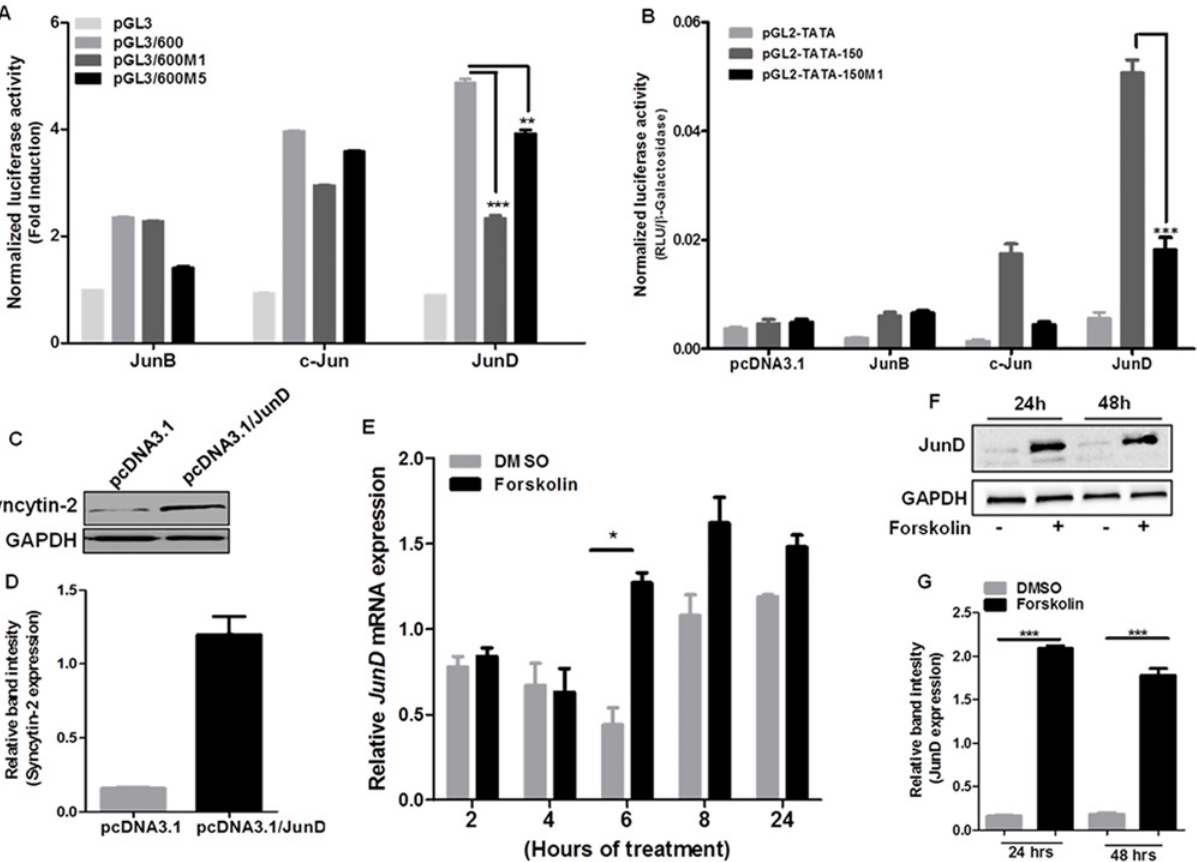
Fig 6. Modulation of Syncytin-2 promoter activity by various Jun family members. ( A ) JunB, c-Jun and JunD expression vectors (vs. control vector pcDNA3.1) (200 ng) were co-transfected with pGL3/600, pGL3/600M1, pGL3/600M5 or pGL3basic (200 ng) along with pRcActin-LacZ (200 ng) in BeWo cells. (B) . JunB, c-Jun and JunD expression vectors (vs. control vector pcDNA3.1) (200 ng) were co-transfected with pGL2-TATA-150, pGL2-TATA-150M1 or pGL2-TATA (200 ng) along with pRcActin-LacZ (200 ng) in BeWo cells. At 48 h post-transfection, cells were harvested and assayed for luciferase activity. Luciferase activities were normalized for β -galactosidase activity and are expressed as the mean normalized RLU ± S.E.M of three independent transfections for panel B . In panel A , mean fold induction values were determined by calculating normalized luciferase activities over values from corresponding control vector-transfected cells. Results are representative of three independent experiments. ( C-D ) BeWo cells were treated or not with forskolin for 24 h and cell extracts were subsequently analyzed for Syncytin-2 and GAPDH protein levels by Western blot. Band intensities for Syncytin-2 are depicted in ( D ) following normalization with GAPDH signals and were calculated as the mean ratio ± S.E.M. from three independent experiments. ( E-G ) BeWo cells were stimulated or not with forskolin for 48 h from which RNA ( E ) and proteins ( F-G ) were subsequently isolated. RT-PCR analyses were conducted and amplified JunD cDNAs were quantified for each time point following normalization with amplified β -actin mRNA ( E ), For Western blot analyses, anti-JunD and anti-GAPDH antibodies were used and JunD protein levels normalized for GAPDH were calculated and compared ( G ) ( * p < 0.05; ** p < 0.01; *** p <